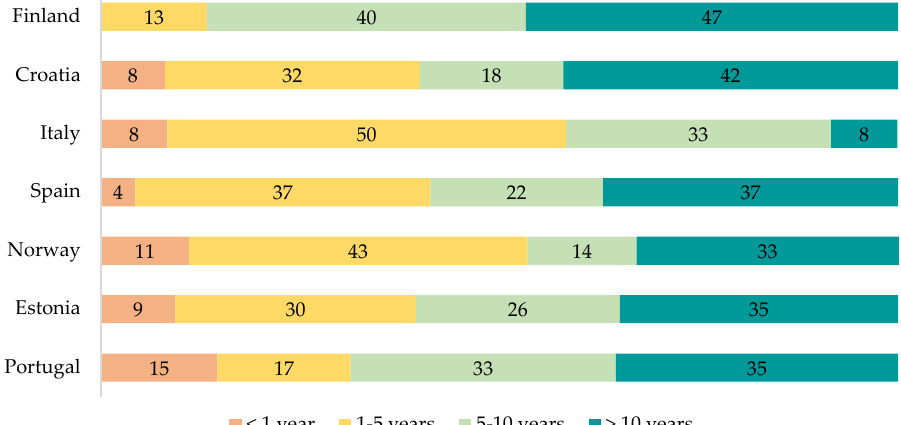
Figure 3. Relative distribution of time of activity by country (%).